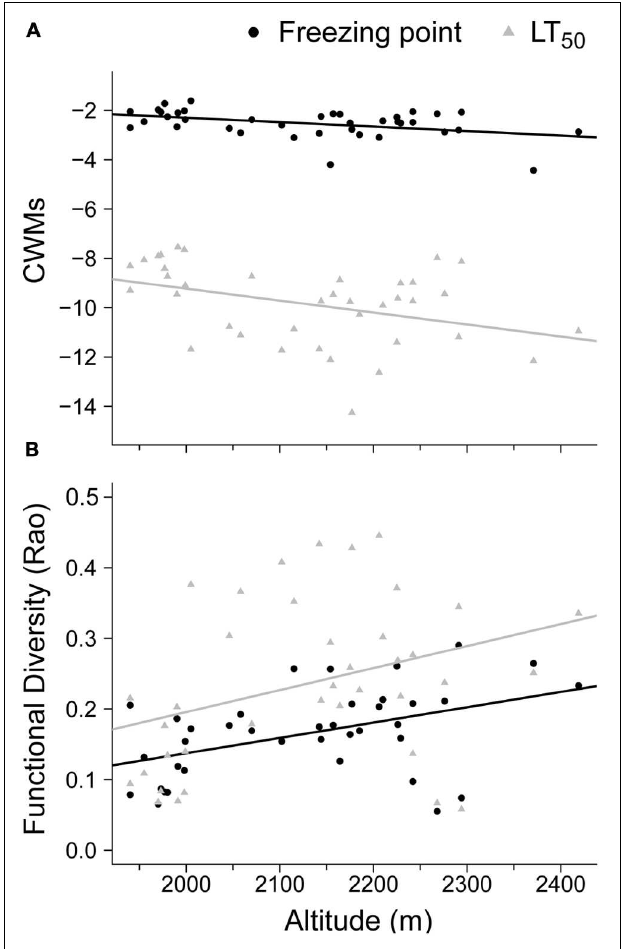
FIGURE 1 | Community response to summer freezing resistance based on different functional components and the altitudinal gradient considered across 38 plots. The significant relationships between altitude and: (A) community weighted means (CWMs) and (B) functional diversity (FD – Rao) are shown for the freezing point (FP, ◦ C; solid circles) and freezing temperature damage (LT 50 , ◦ C; gray triangles). Lines represent the significant regression linear model